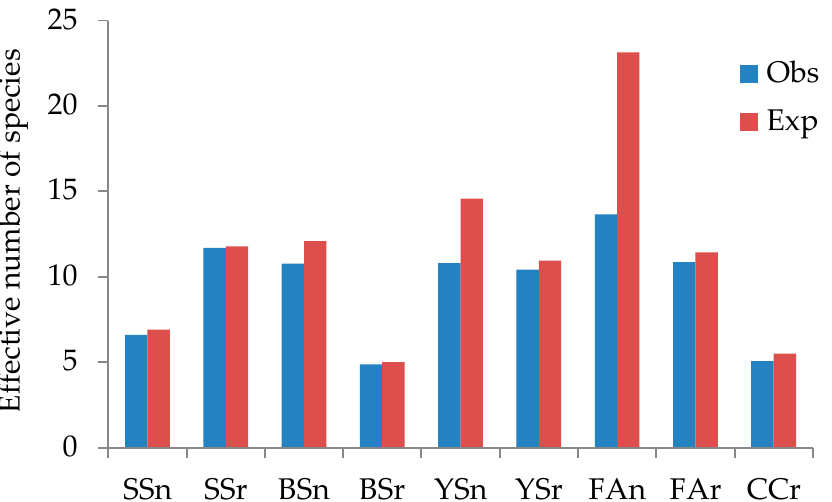
Figure 5. Temporal variation in observed and expected true diversity of Trichoptera in the Sierra de Juárez, Oaxaca, Mexico.